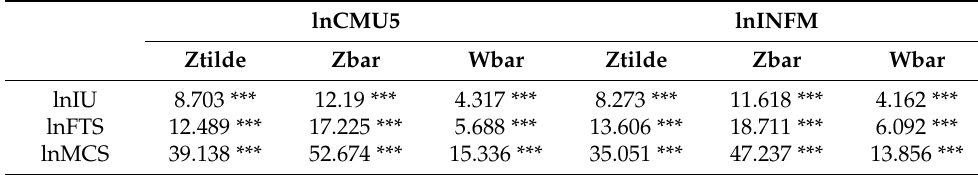
Table 2. Panel Granger causality test results.